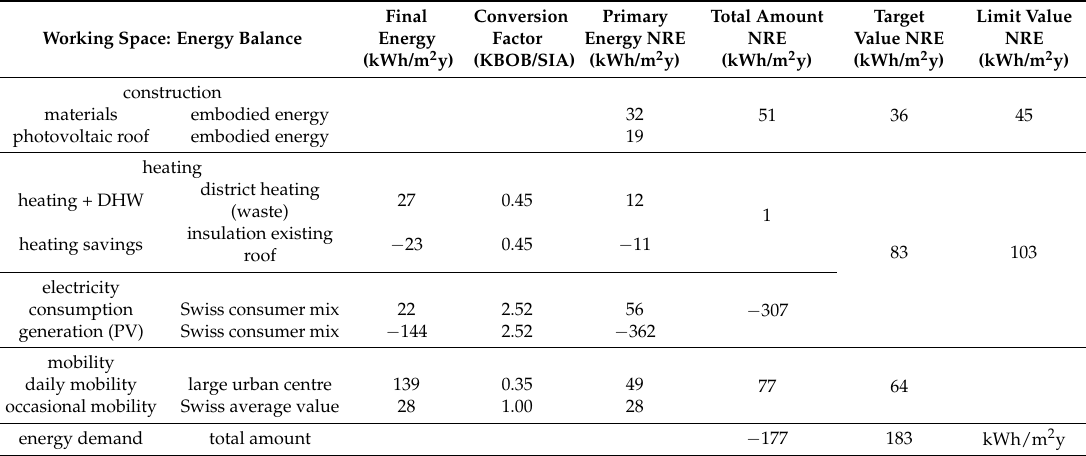
Table 1. Estimated performances in non-renewable primary energy (NRE), rounded